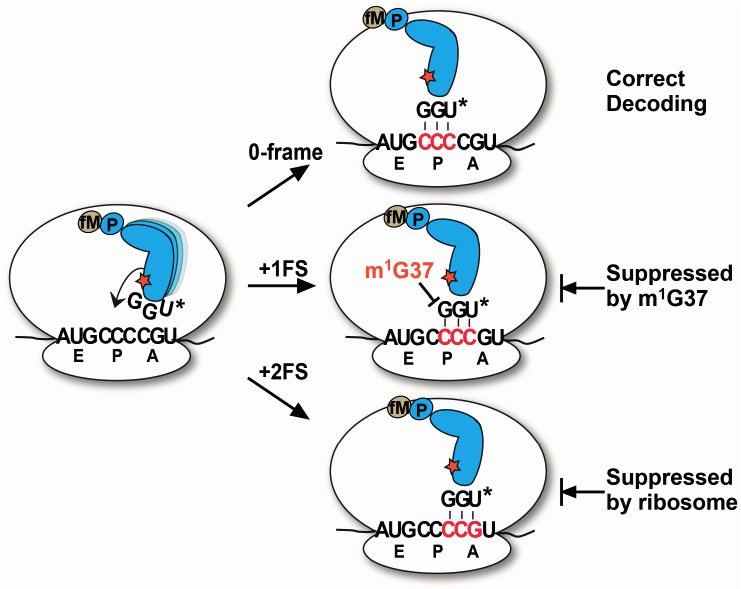
Figure 6. A model of the propensity of the UGG isoacceptor tRNA Pro to shift due to the presence of the cmo 5 U34 base (shown as U * ). The 0-frame decoding is shown on the top; the +1FS is shown in the middle, which is suppressed by m 1 G37 in the anticodon loop of the tRNA; and the +2FS is shown at the bottom, which is suppressed by the ribosome due to the lack of further peptidyl transfer. The tRNA is shown in blue, carrying the fMP dipeptide, and m 1 G37 is shown as a red